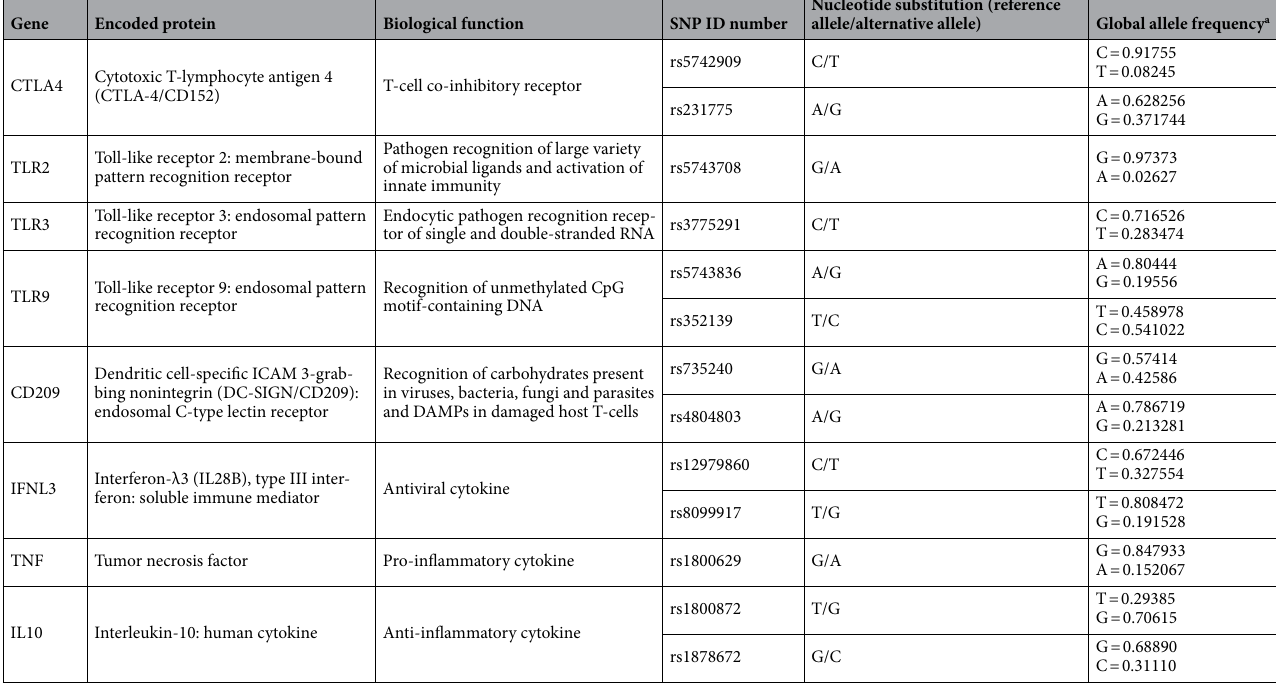
Table 1. Description of the selected candidate SNPs for the present study. DAMP damage-associated molecular pattern; SNP single-nucleotide polymorphism. a Obtained from ALFA Allele Frequency (available at: https:// www. ncbi. nlm. nih. gov/